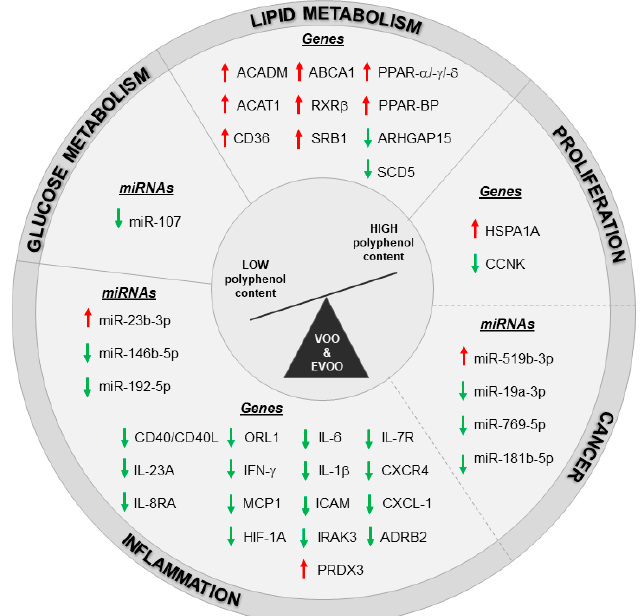
Figure 1. Transcriptomic changes induced by high polyphenols VOO and EVOO intake in healthy and unhealthy population. Red arrows: up-modulated genes / miRNAs, green arrows: down-modulated genes / miRNAs. Dashed line indicates an overlapping in the modulation of some genes and miRNAs between inflammation, proliferation and cancer pathways.